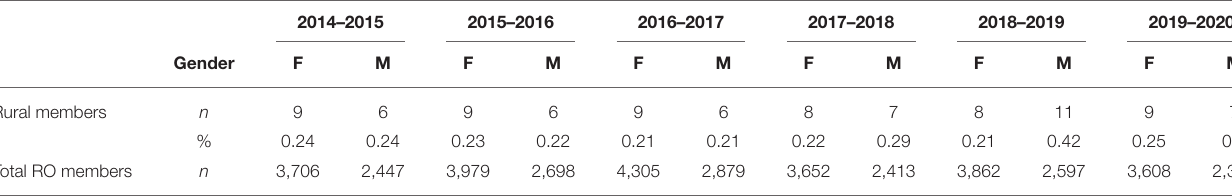
TABLE 3 | Rurality of PSO membership by gender in all